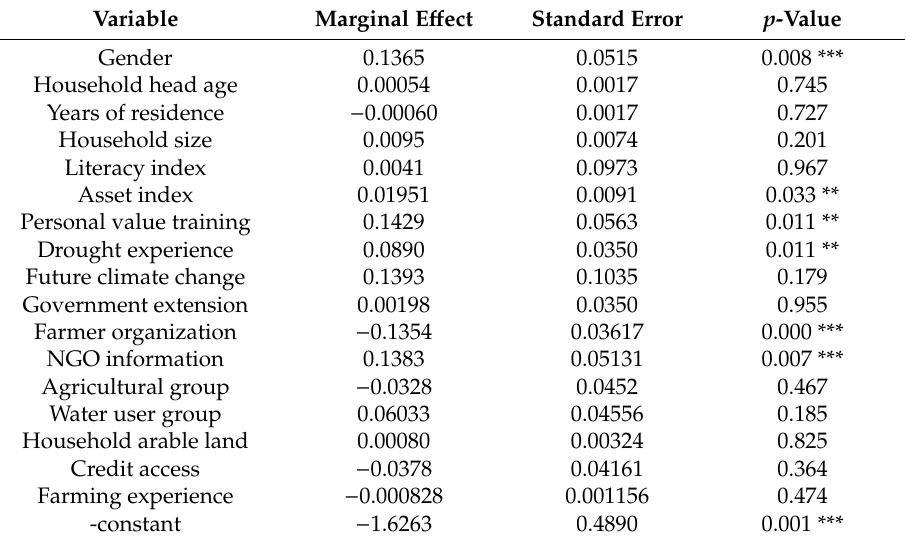
Table 3. Probit analysis results on the adoption of MT by